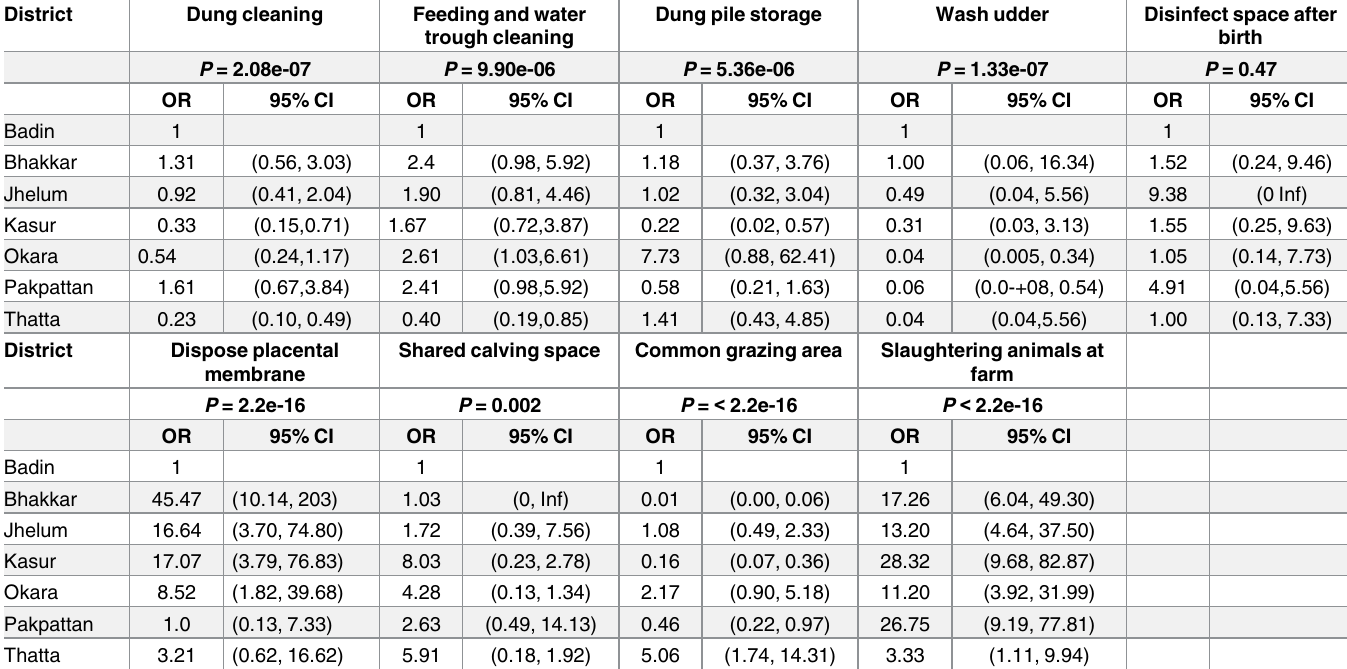
Table 6. Summary of the univariable models for herd management risky practicesshowing the effect of District. Columnsof the table refer to specific practices (outcome variables) and rows refer to particular districts. Shown are the odds ratio (OR) and 95% confidenceinterval (95% CI) for the OR, relative to the reference district Badin in the Sindh province(OR =